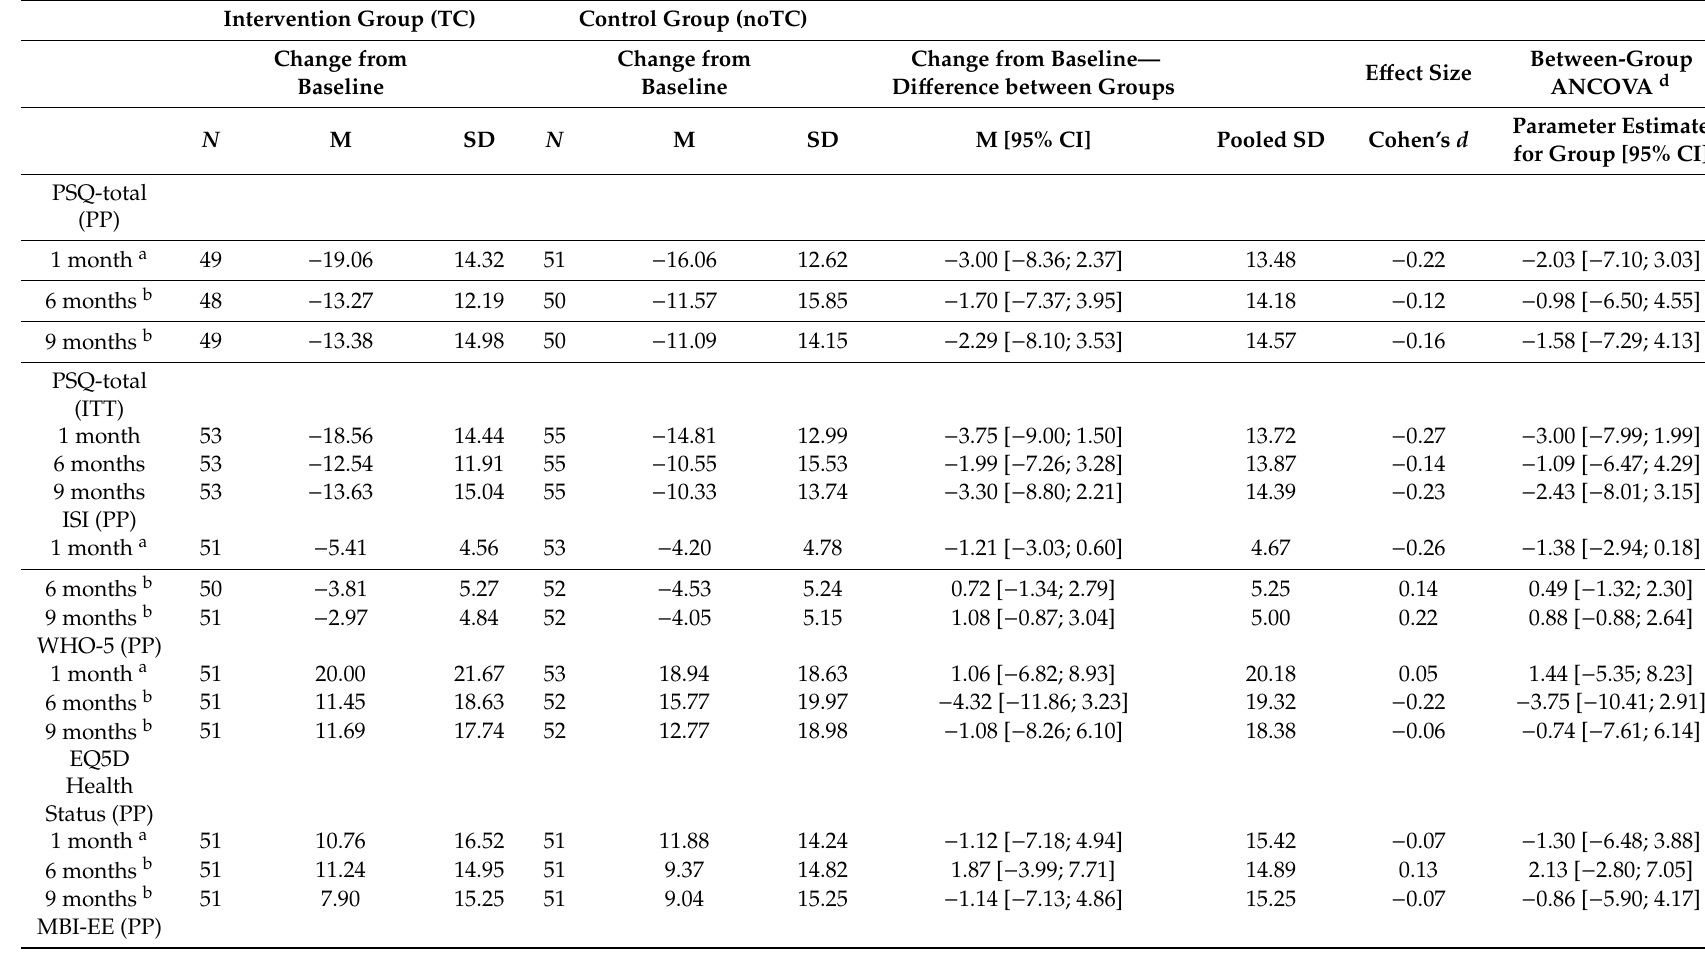
Table 3. Changes in outcomes from baseline to 1-, 6- and 9-month post-intervention follow-up (PP analysis, N = 103 at 9 months) and ITT analysis for the primary outcome PSQ-total considering all randomized persons (participants N = 103 and drop outs N = 5) with missing-value imputation using the “Last Observation Carried Forward”